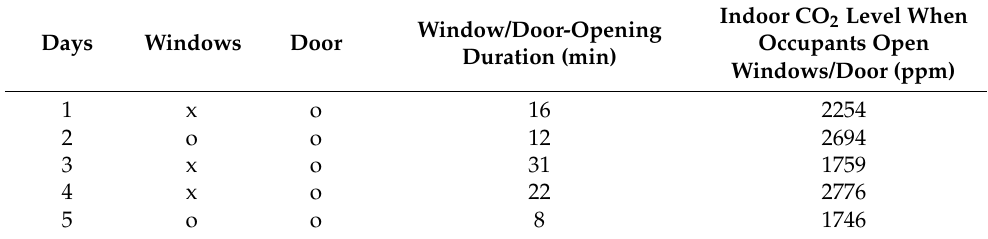
Table 3. Summary of opening window/door operation during occupied